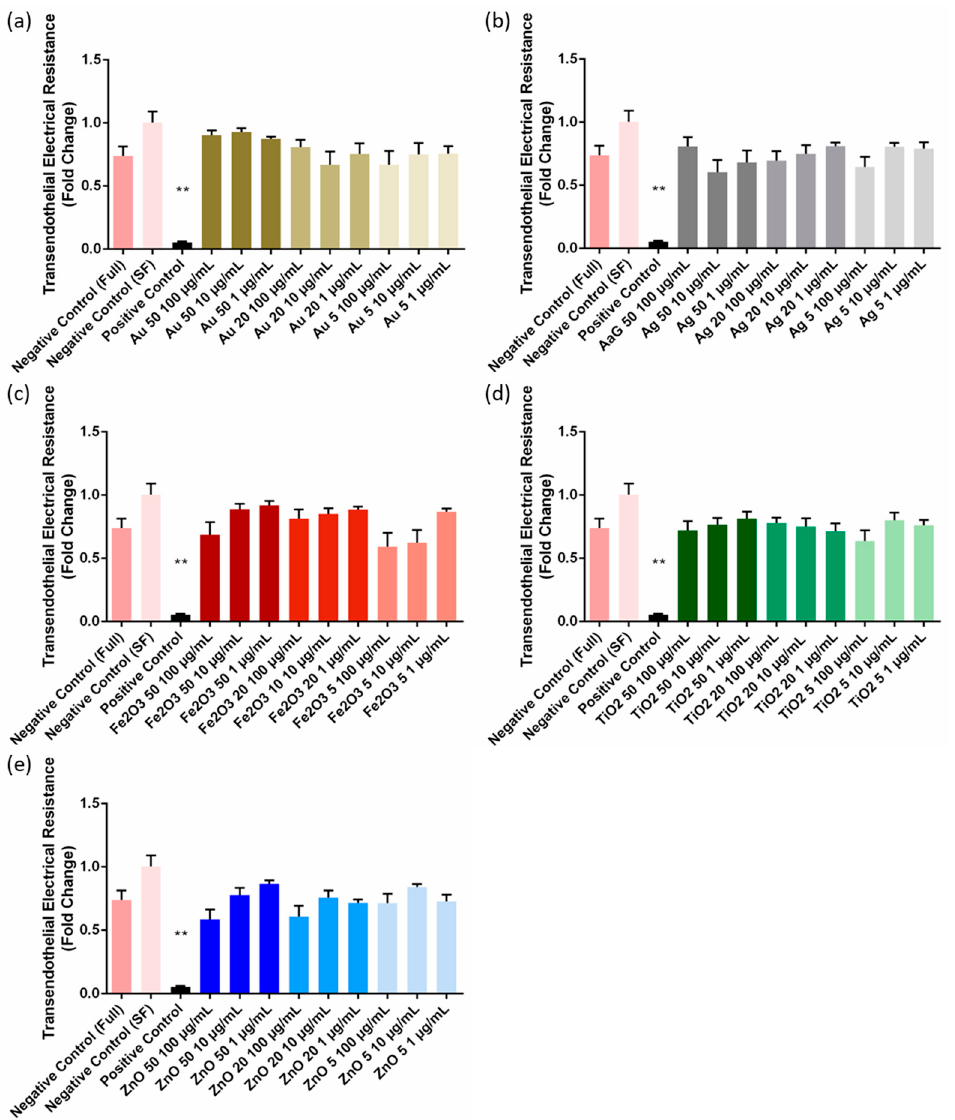
Figure 3. Fold change in transendothelial electrical resistance values following 12-h incubation with ( a ) gold, ( b ) silver, (c) iron (III) oxide, ( d ) titanium dioxide, and ( e ) zinc oxide nanoparticles of different concentrations and sizes. Colour Key for all graphs: Au = Gold, Ag = Grey, Fe 2 O 3 = Red, TiO 2 = Green, and ZnO = Blue. ** = 0.001 < p < 0.01, SF = serum free media, Full = media containing serum.